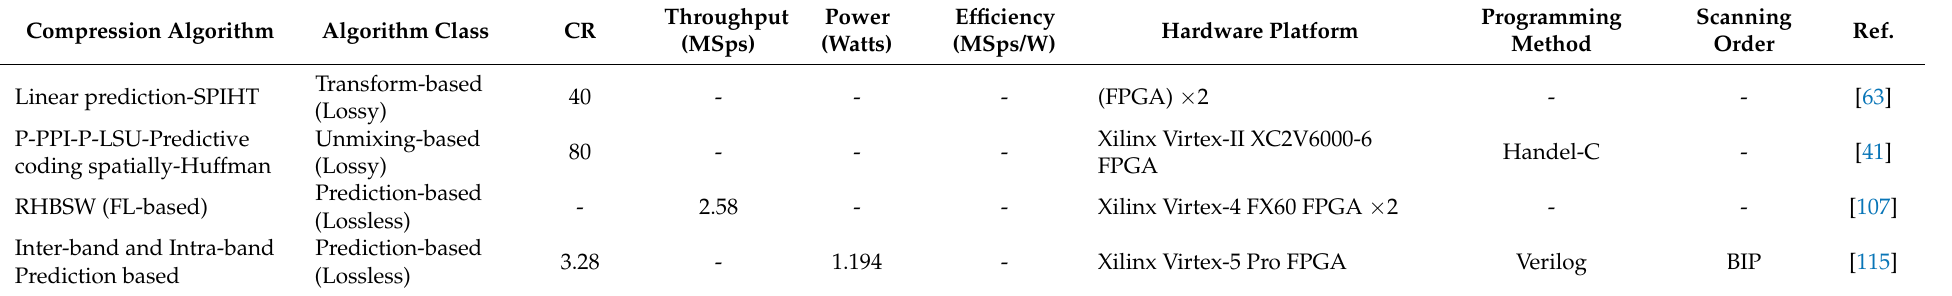
Table 12. Comparison of the proposed compression system validated using the AVIRIS Hawaii